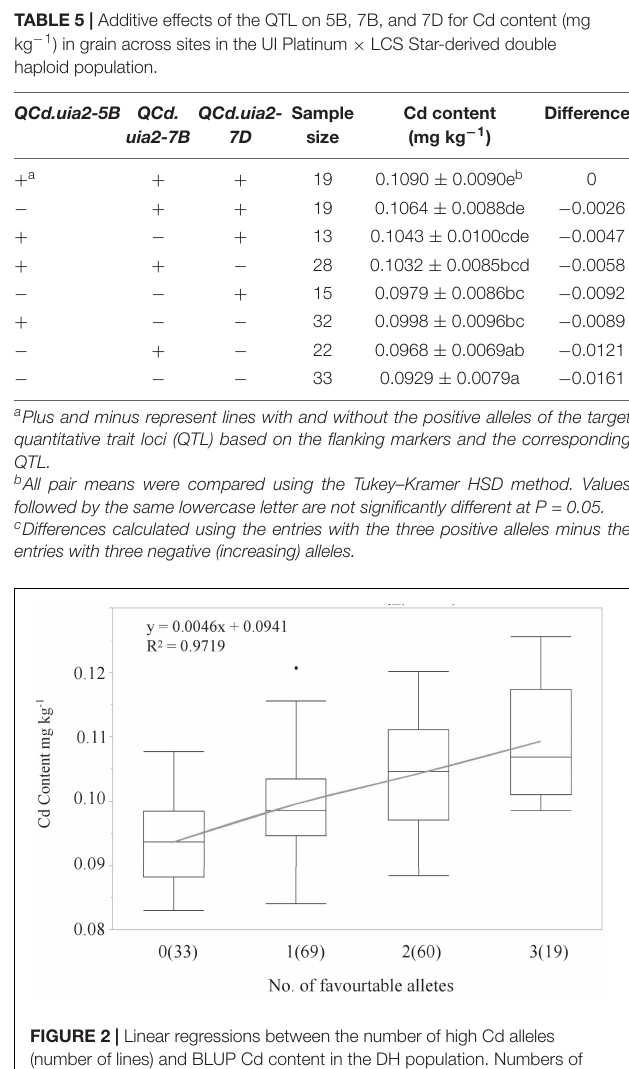
( Table 6 ). TraesCS7B02G320900 is homologous to OsHMA2 ( Os06g0700700 ) and TraesCS7B02G322900 is homologous to OsMSRMK3 ( Os06g0699400 ) in rice. TraesCS7B02G320900 and TraesCS7B02G322900 were named TaHMA2 and TaMSRMK3,